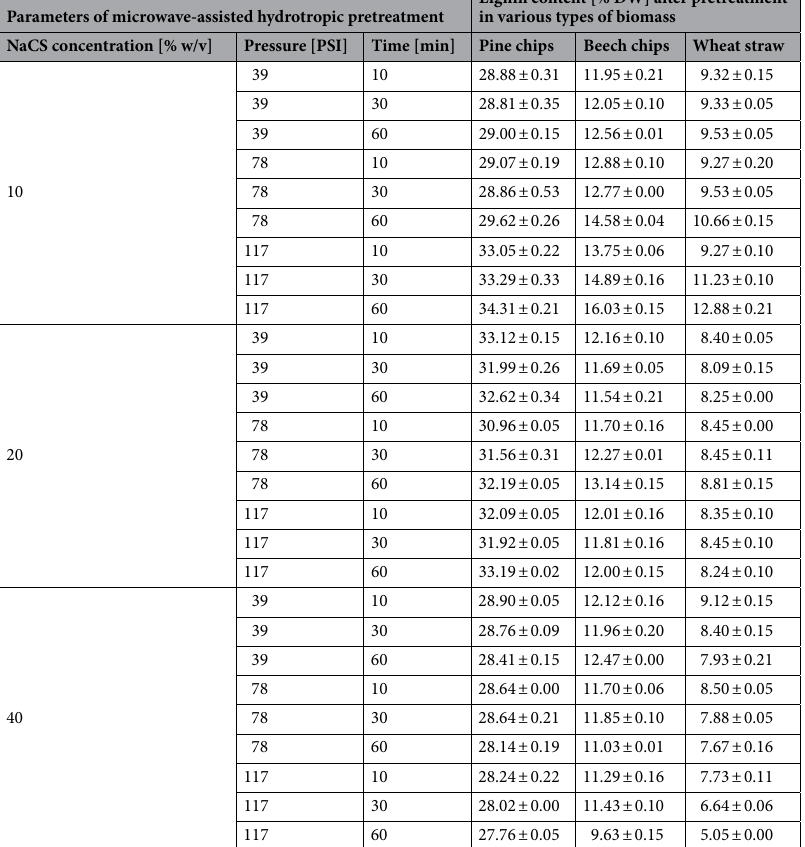
Table 3. Lignin concentration in various types of biomass after microwave-assisted hydrotropic